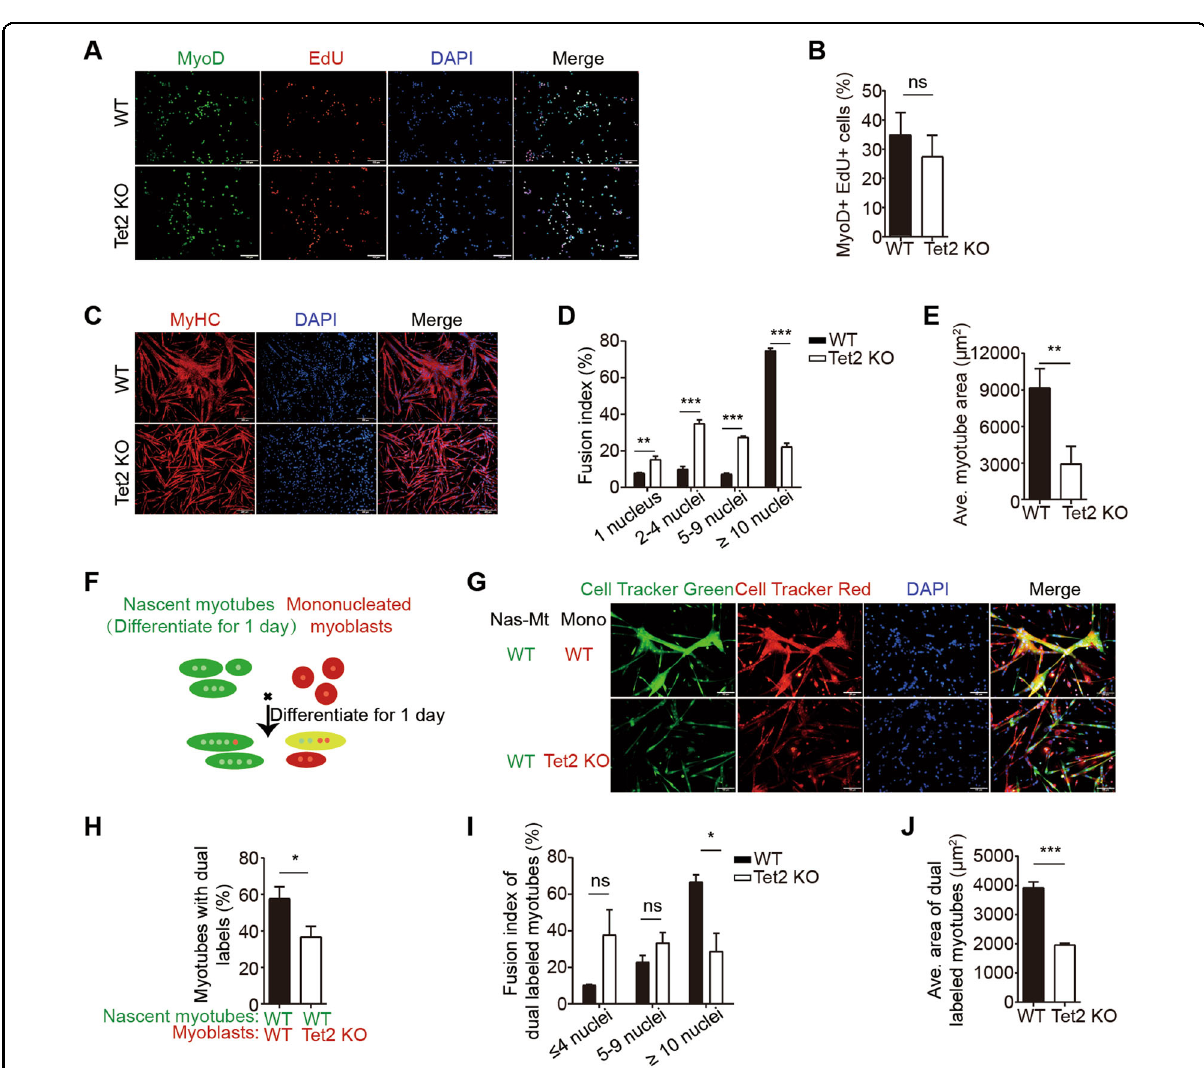
Fig. 2 Tet2 KO myoblasts display fusion defects in vitro. A Immuno fl uorescence staining of MyoD and EdU in myoblasts isolated from WT or Tet2 KO mice. Scale bars, 100 µm. B Quanti fi cation of the percentage of MyoD + EdU + myoblasts ( n = 3). C Immuno fl uorescence staining of MyHC in differentiated myotubes. Scale bars, 200 µm. D Quanti fi cation of the fusion index in differentiated myotubes ( n = 3). E Quanti fi cation of the average area in differentiated myotubes ( n = 3). F Scheme of the second phase fusion assay. G Images of the second phase fusion assay results. Scale bars, 100 µm. H Quanti fi cation of the percentage of the dual labeled myotubes ( n = 3). I Quanti fi cation of the fusion index of the dual labeled myotubes ( n = 3). J Quanti fi cation of the average areas of dual labeled myotubes ( n = 3). * p < 0.05, ** p < 0.01, *** p <